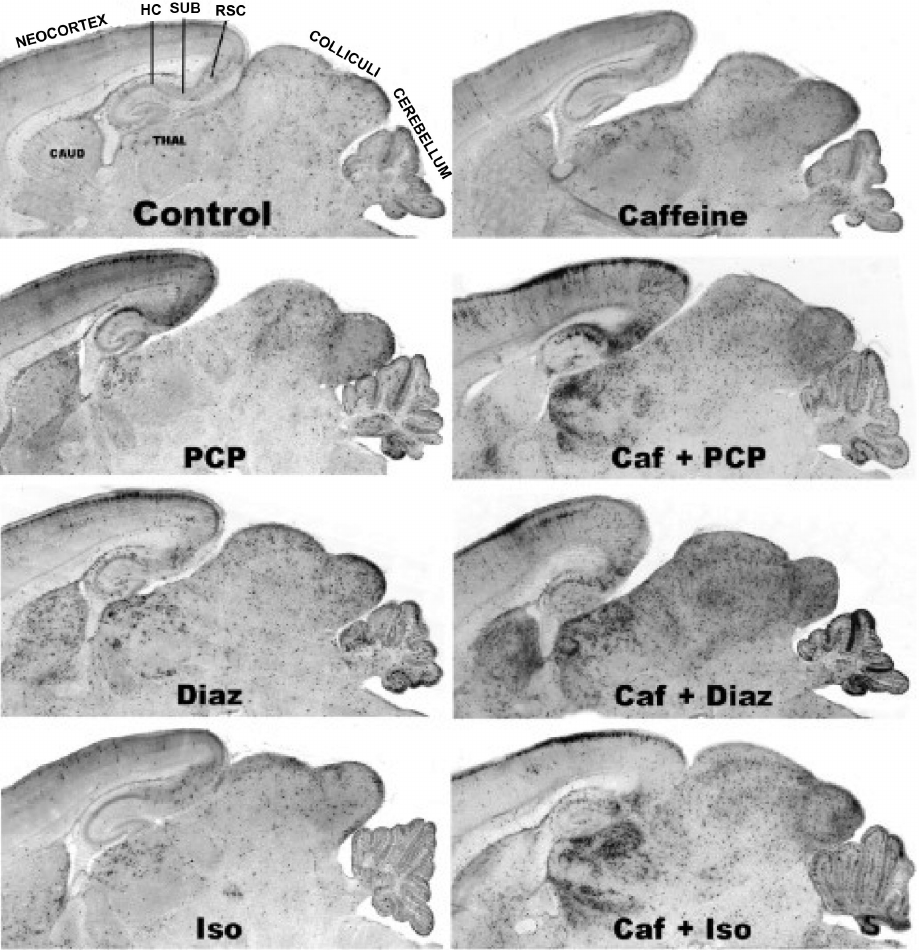
Figure 5. Regional Patterns of Neuroapoptosis. All panels are stained by activated caspase 3 (AC3) immunohistochemistry. In the control brain the AC3-positive profiles (dark specks) are distributed in a relatively sparse and random pattern over many brain regions. In the brains exposed to caffeine, PCP, diazepam (Diaz) or isoflurane (Iso), the density of AC3-positive profiles is moderately increased, especially in neocortex, hippocampus (HC), subiculum (SUB), retrosplenial cortex (RSC), Caudate (CAUD), Thalamus